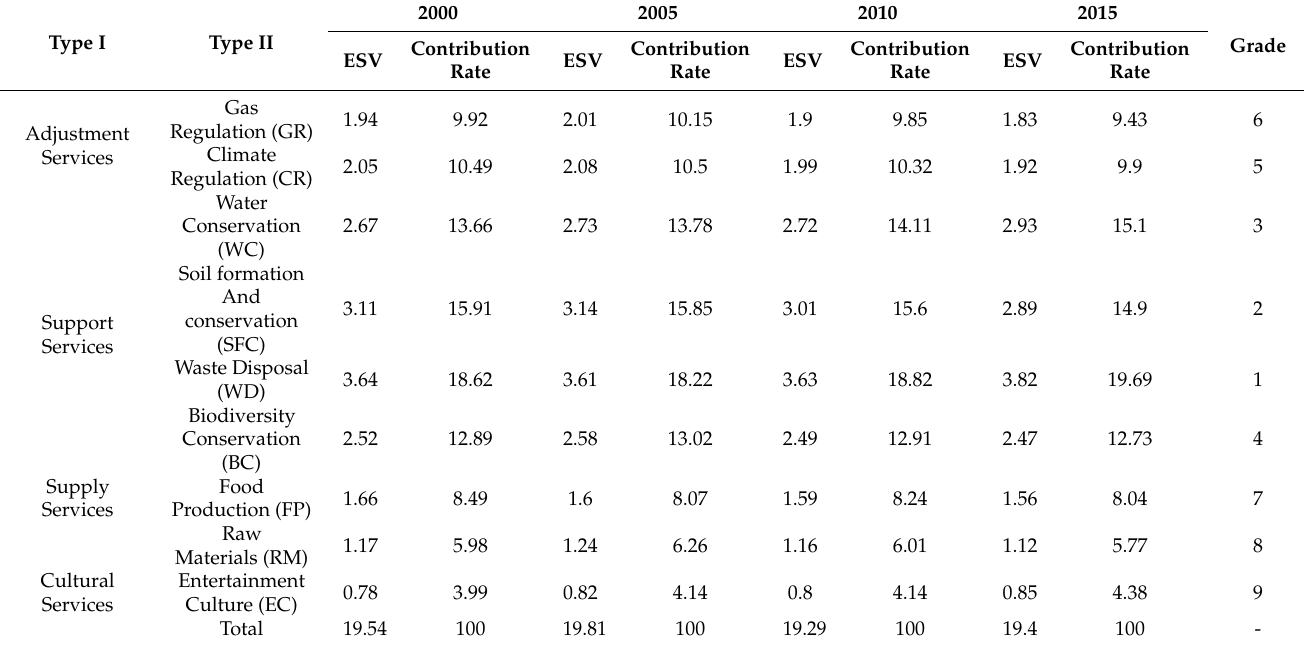
Table 4. Ecosystem service value (1 × 10 8 CNY) and the contribution rate (%) of the Qihe